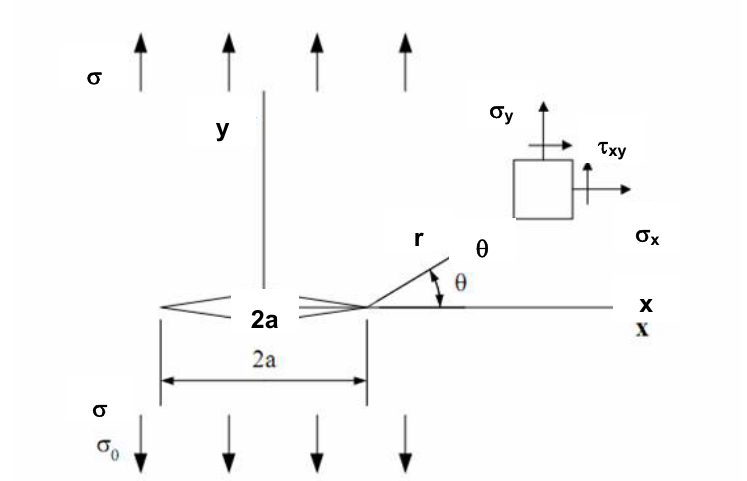
Figure 6. Scheme of a crack of length a in an infinite body. σ and τ denote tensile and shear stresses